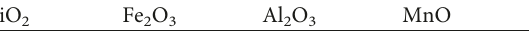
Table 2: Chemical composition of IFS (%). SiO 2 Fe 2 O 3 Al 2 O